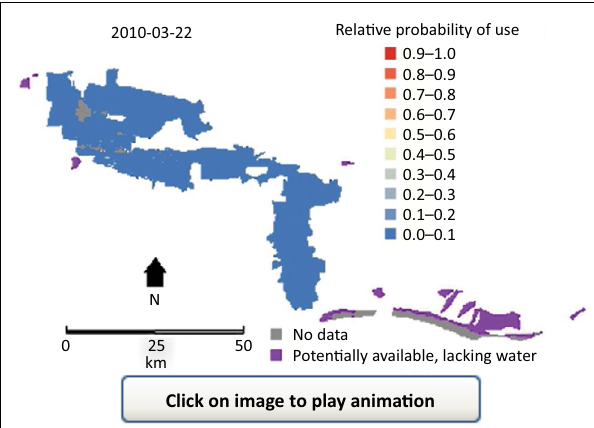
Areas of ‘no data’ represent locations dominated by water, such as Darlington Dam in the north and the coastline of the Indian Ocean in the south, as well as areas with Moderate Resolution Imaging Spectroradiometer pixel reliability values greater than 1. Areas in purple fall within Addo Elephant National Park but currently lack permanently available fresh water, making them unsuitable for elephant use. To view the animation online, visit https://youtu.be/RzptVzB_7CM FIGURE 4-A4: Animation of predicted space use by female elephants across Addo Elephant National Park, South Africa. Predicted use reflects midday (12:00) step selection function model extrapolations to the full Addo Elephant National Park, including areas that are currently not accessible to elephants. Predictions represent 16-day periods from 06 March 2010 to 21 March 2013, corresponding to the Moderate Resolution Imaging Spectroradiometer composites used for analysis (see the main text for